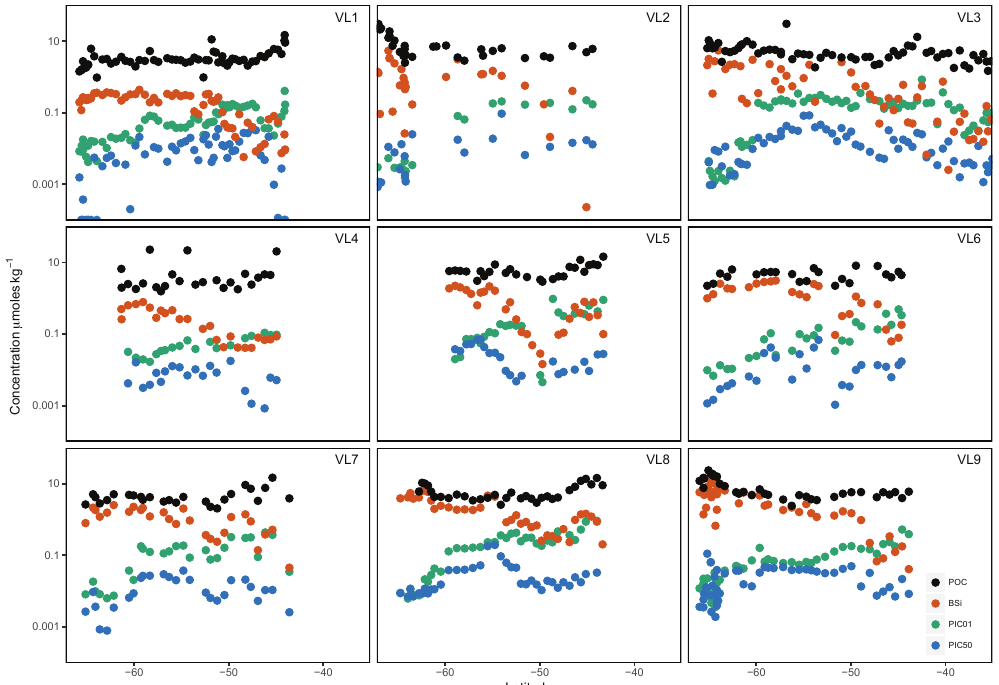
Figure 3. Latitudinal variations in POC, BSi, PIC50 and PIC01 concentrations for each voyage leg. See Table 1 for voyage leg details and Fig. 1 for sample